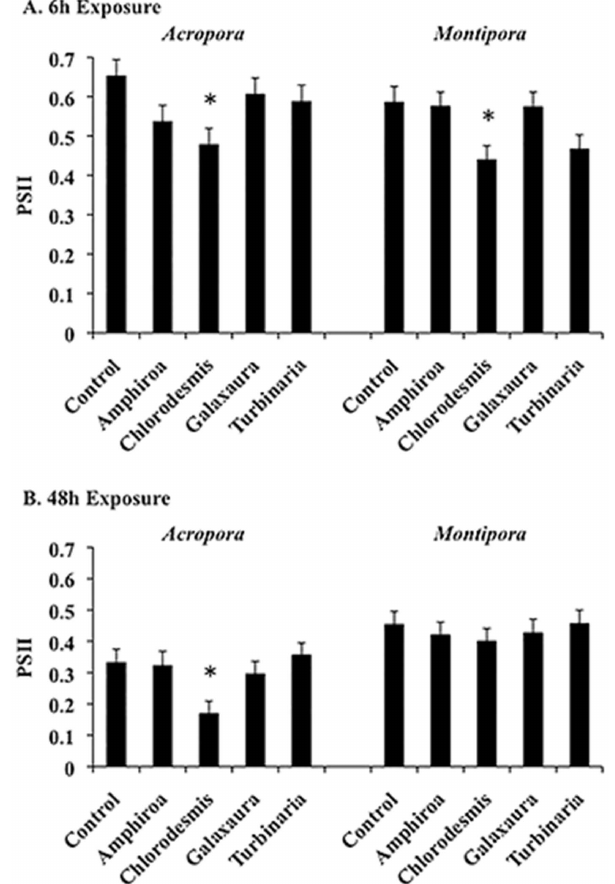
Fig. 1. Quantification of photosystem II (PSII) effective quantum yield of Symbiodinium (mean ¡ SE) in Acropora millepora and Montipora digitata coral after 6 h (A) or 48 h (B) exposure to macroalgal tissue. N 5 8–10 coral fragments per treatment. Significance was determined by ANOVA and treatments were compared to respective controls using Dunnett’s post-hoc test. * indicates P ,